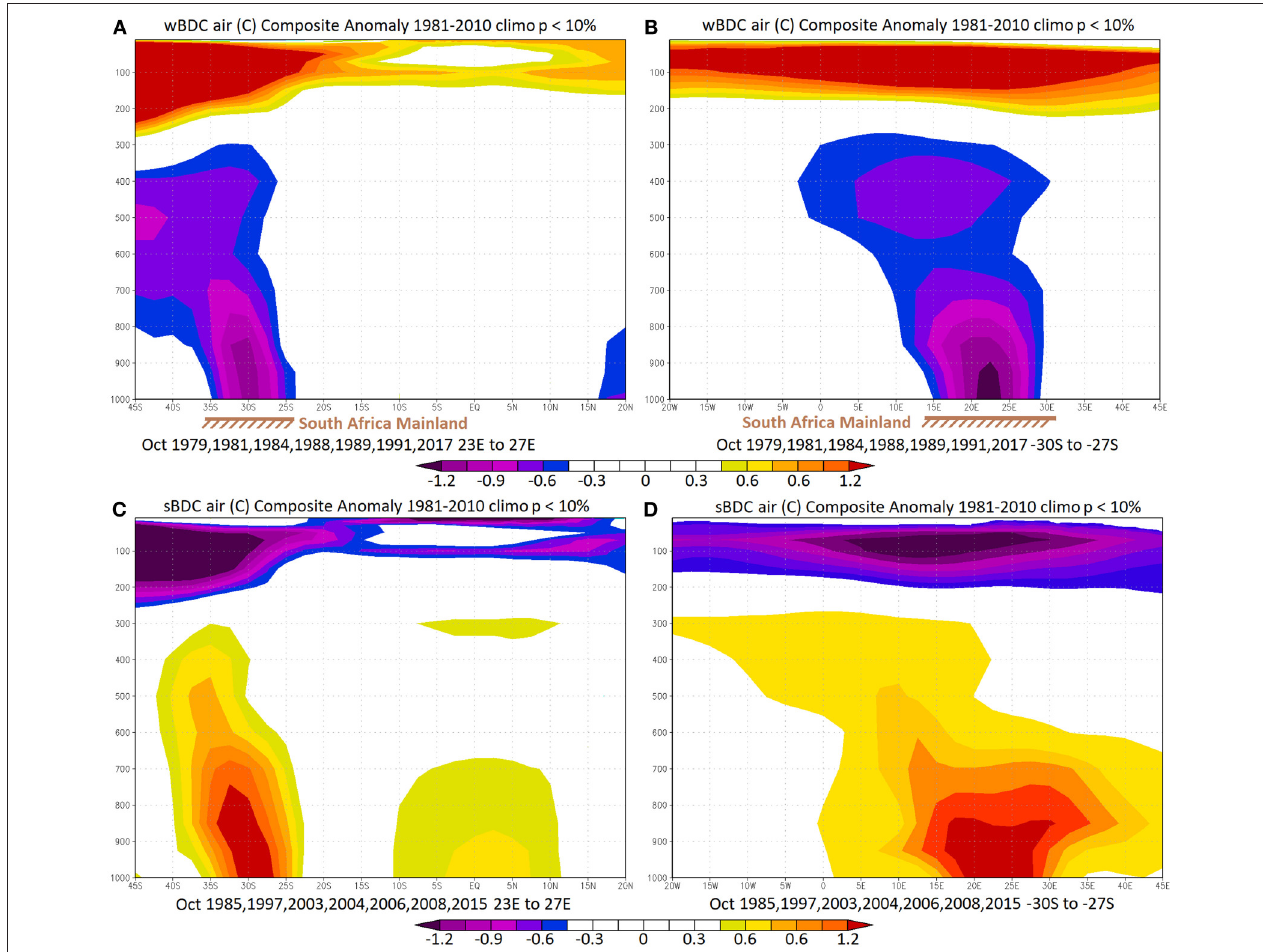
FIGURE 5 | Vertical air temperature pattern for the wBDC composites averaged over (A) 21 ◦ E to 25 ◦ E and extending from 40 ◦ S to 20 ◦ N, (B) 33 ◦ S to 30 ◦ S and covering 20 ◦ W to 45 ◦ E (C,D) same as in (A,B) respectively but for sBDC composites. Years for the composites are indicated in the insert and were derived from October data spanning from 1979 to 2017. The anomalies are with respect to the 1981-2010 climatology. Shaded regions are significant above the 90% confidence